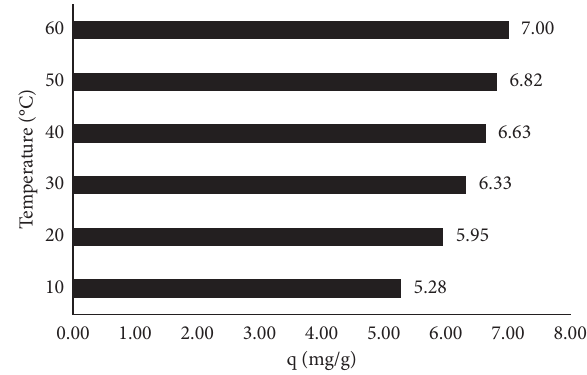
Figure 8: Influence of temperature on GV